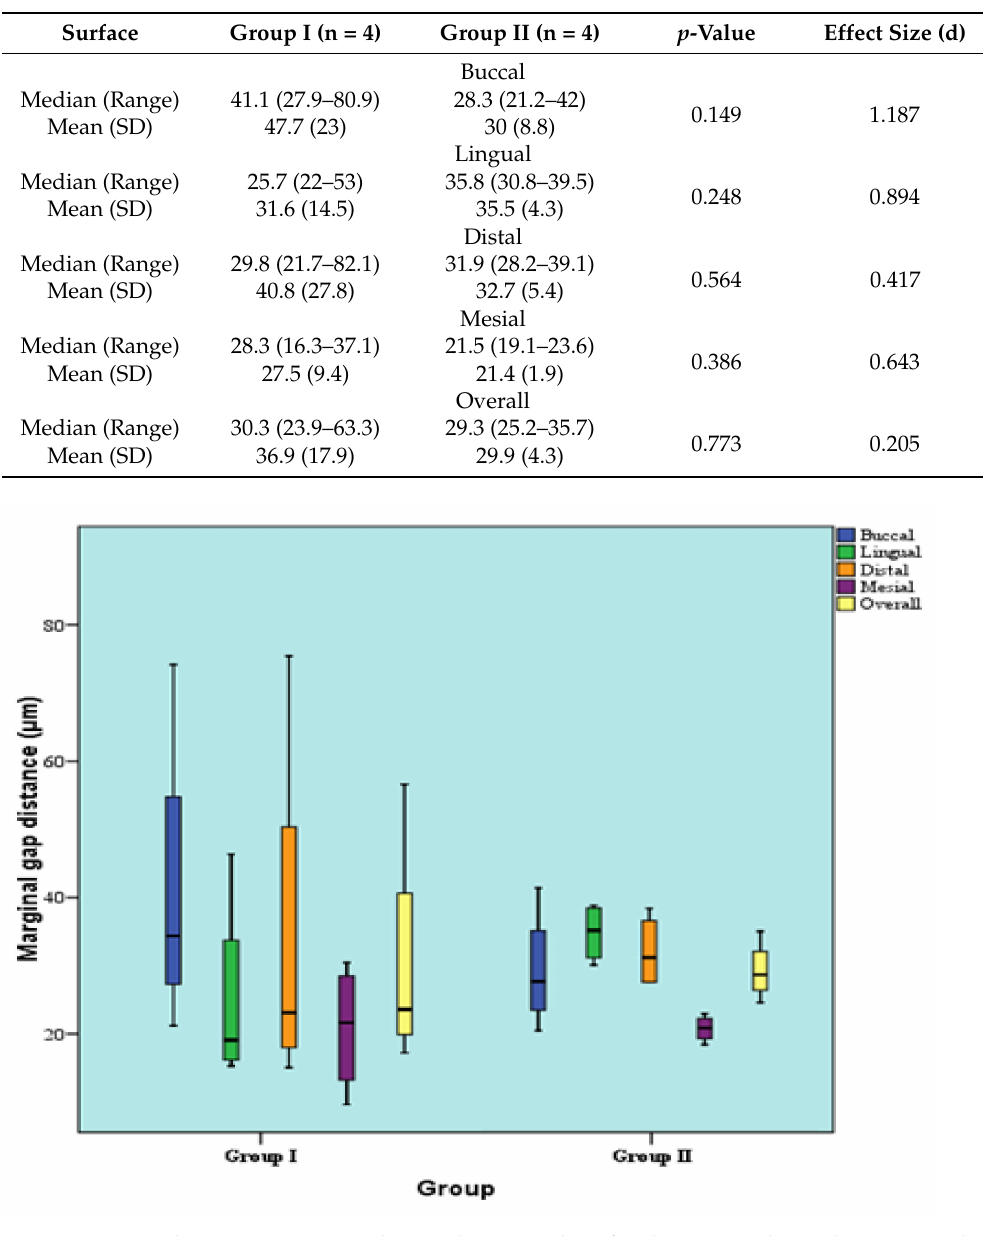
Figure 15. Box plot representing median and range values for the marginal gap distances in the two groups (distal